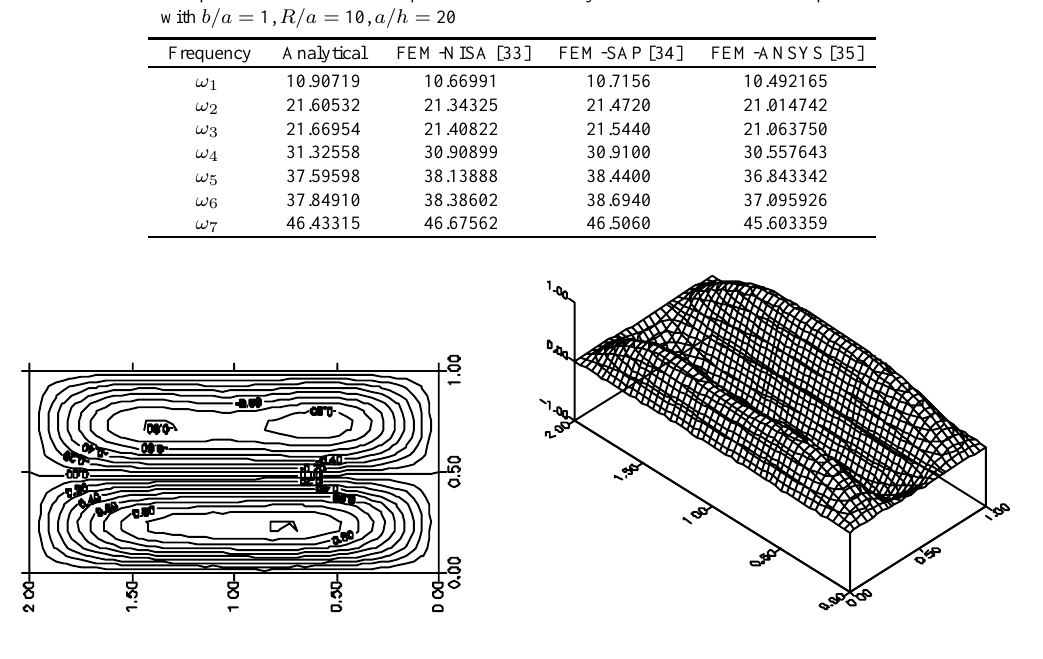
(a) Mode shape of U3(3,1) for an isotropic shell panel with b/a = 2, R/a = 10, a/h = 10